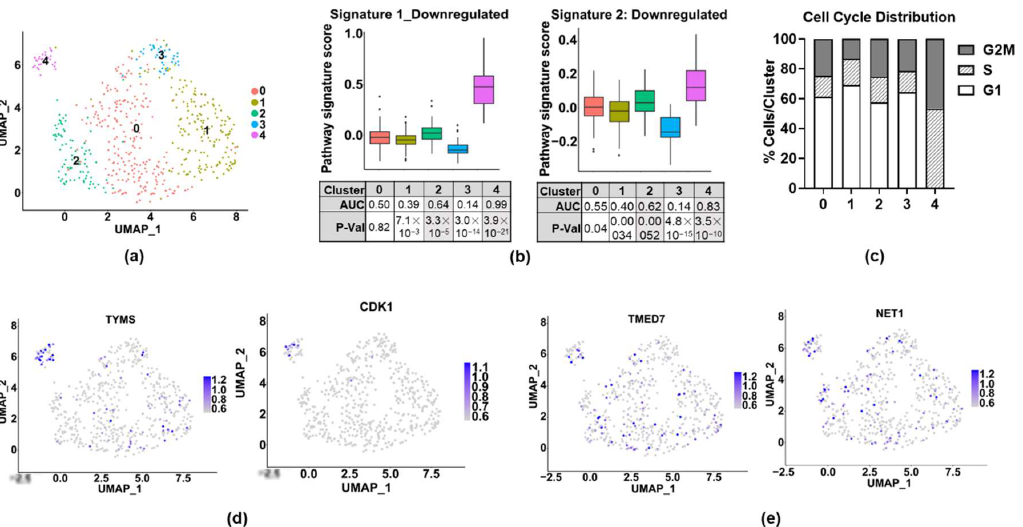
Figure 4. ER activity and gene signatures in invasive cell subpopulations. MCF-7-CA-IKKβ cells were treated with E2 + DOX for 72 h, then seeded onto collagen-coated (10 μg/cm 2 ) transwell inserts. After 24 h, invaded (INV+) cells were collected from the bottom of the insert and sequenced using inDrop scRNA-Seq. ( a ) Bi-dimensional representation of single-cell transcriptomes of 543 MCF-7 CA-IKKβ invasive cells visualized in a UMAP plot. ( b ) Box plots to show enrichment of Signature 1 and Signature 2 genes. ROC analysis was used to generate AUC values, which represent signature enrichment in each cluster of INV+ cells. Significance of enrichment was tested by Wilcox test. AUC > 0.6 and p < 0.01 were considered significant. ( c ) Cell- cycle analysis of scRNA-seq data was conducted using Cell-Cycle Scoring and Regression vignette [33], provided by Seurat package v. 3.1. ( d ) Feature plots for two Signature 1 genes. ( e ) Feature plots for two Signature 2 genes. 3.5. ER-Regulated Gene Signatures Are Associated with Metastasis and Poor Patient Outcome To determine whether either Signature 1 (i.e., proliferation) or Signature 2 (i.e., organelle/vesicle assembly) are associated with aggressive disease, we first interrogated publicly available scRNA-seq datasets from metastatic-ER+-patient-derived xenograft (PDX) models [26] (GSE131007). Two PDX cell lines, UCD4 and UCD65, were used for the analysis. For each model, primary or metastatic tumors were harvested for scRNA-seq analysis, with bone and brain metastases collected from UCD65, and liver metastases collected from UCD4. The clustering of the datasets for each model was performed (Figure 5a,e), and the identity of the cells in each cluster was defined by their source, either coming from a primary tumor or from a metastatic site (Figure 5b,f). In the dataset from the PDX model UCD4, both Signatures 1 and 2 were highly enriched in Clusters 4 and 5, which consisted of cells found in the primary tumor or liver metastases, respectively (Figure 5c,d). Signature 2 was also highly enriched in Cluster 1, which was found primarily in liver metastases. In the PDX UCD65 dataset, Signature 1 was found to be enriched only in Cluster 2, which consisted of cells found in both brain and primary tumors (Figure 5g). In contrast, Signature 2 was found to be enriched in Cluster 1 (found in bone metastases), Cluster 2 (primary and brain metastases), and Cluster 4 (brain metastases). Again, overlapping genes between the two signatures played a key role for Signature 2 enrichment but not Signature 1 (Supplemental Figure S1). Thus, both signatures were found to be enriched in different cell populations of primary and metastatic PDX tumors, suggesting the potential relevance of these ER-regulated invasive gene signatures to the metastatic process, as well as supporting the concept that ER may function differently in different cell subpopulations.